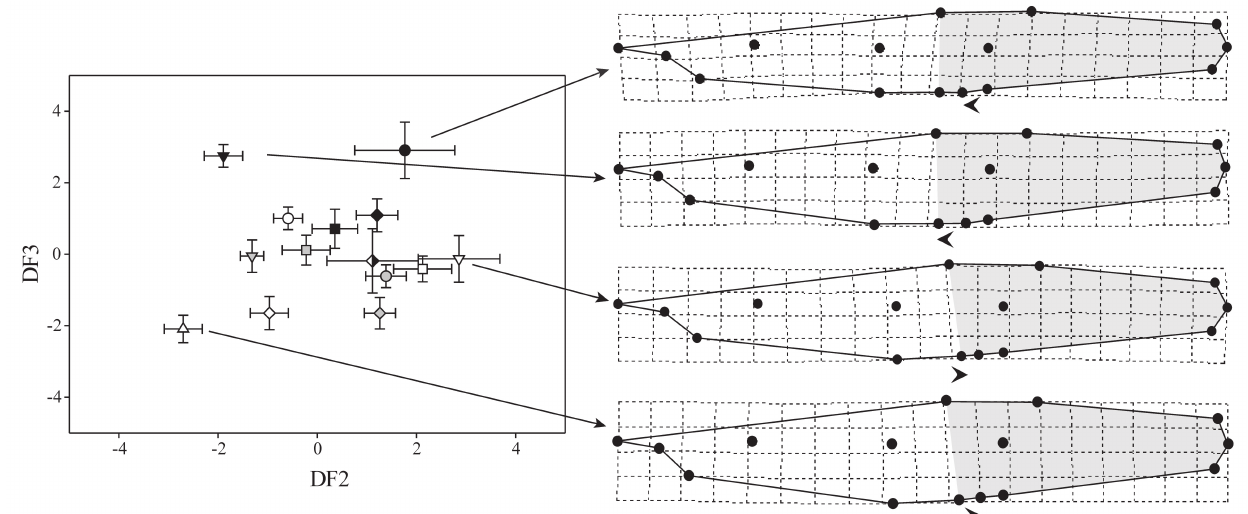
Fig. 8. Geometric Morphometric Analysis applied to O. hatcheri individuals. Left: plot of DF3 vs. DF2 showing means and 95% confidence intervals by sampling sites (locality labels as in Fig. 1) NIHL (white triangle), CDP (black circle), 7: PELE (gray square), PDA (black triangle), MITO (black diamond), CARI (white square), EPU (black and white diamond), RIV (gray circle), ROS (white diamond), AME (black square), CHU (gray diamond), MUS (gray triangle), LBA (white circle), and PUY (white triangle). Right: deformation grids correspond to a relative warps analysis involving only CDP, PDA, and NIHL and PUY. Arrowheads indicate displacement of landmarks relative to consensus. Shaded area remarks relative position of landmarks 5 (anterior insertion of the first dorsal fin) and 12 (distal tip of the pelvic fin onto fish